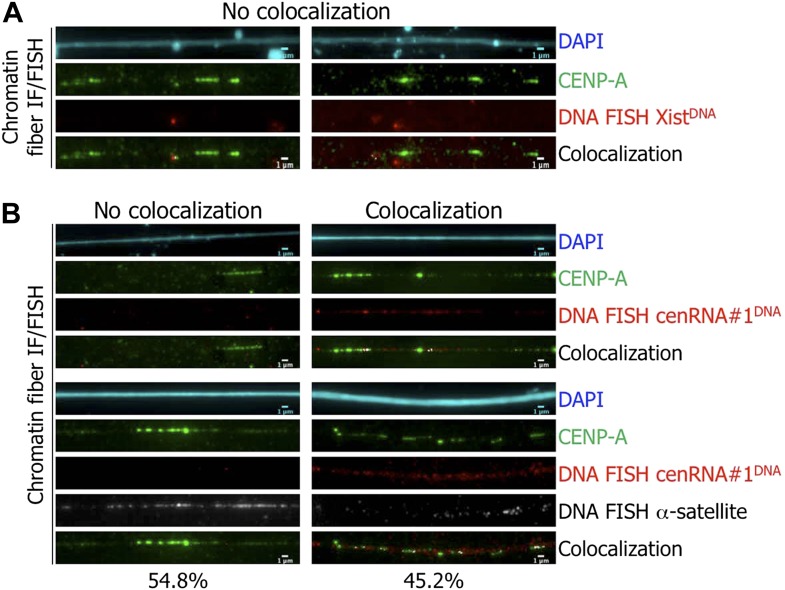
The identified cenRNA#1 transcript associated with CENP-A has a centromeric origin.(A) CENP-A (green) was co-stained with Xist DNA FISH probe (FISH XistDNA, red) on chromatin fibers (cyan, DAPI). Two independent experiments were performed and in each, a minimum of eight chromatin fibers were analyzed per slide (co-localization on the same chromatin fiber between CENP-A and FISHXistDNA = 0/18). Scale bar: 1 µ m. (B) Chromatin fibers were either co-stained by IF/FISH with CENP-A (green) and cenRNA#1DNA (red), or IF/double-FISH with CENP-A (green), cenRNA#1DNA (red) and centromeric α-satellite probes (gray). The DAPI raw image is shown for a representative chromatin fiber (cyan). Two independent experiments were performed and in each, a minimum of eight chromatin fibers were analyzed per slide (co-localization on the same chromatin fiber between CENP-A and cenRNA#1DNA and FISH α-satellite compared to no co-localization = 9/20 vs 11/20). Scale bar: 1 µm. FISH, fluorescencein situ hybridization; IF, immunofluorescence.